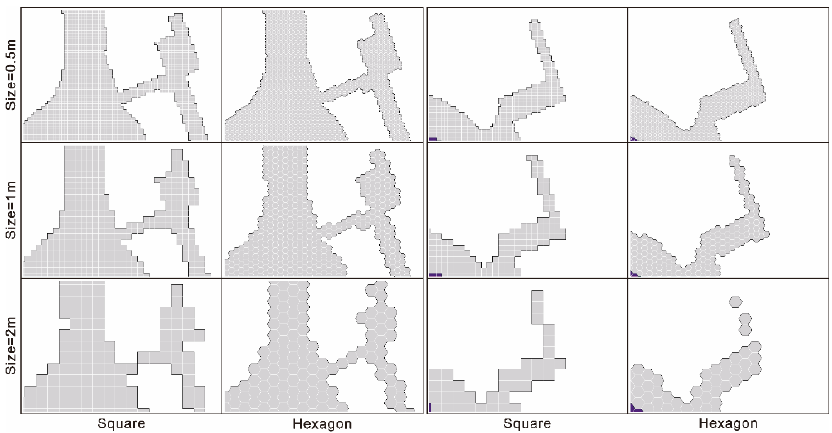
Figure 14. T -shaped (left two columns) and L -shaped (right two columns) subchannel areas. Similarly, in the L -shaped subchannel region (Figure 14) in the upper part of the channel region (10001), both the quadrilateral grid and hexagonal grid obviously can- not accurately describe the environment. At the visual level, it appears that the square quadrilateral grid is closer than the square hexagonal to the real environment shape. How- ever, there is essentially no difference between the experimental results obtained with the two grids for the path planning application. The main reason for this is the same as discussed above, i.e., the hexagonal grid has a larger grid density, which leads to the delayed arrival of inaccurate